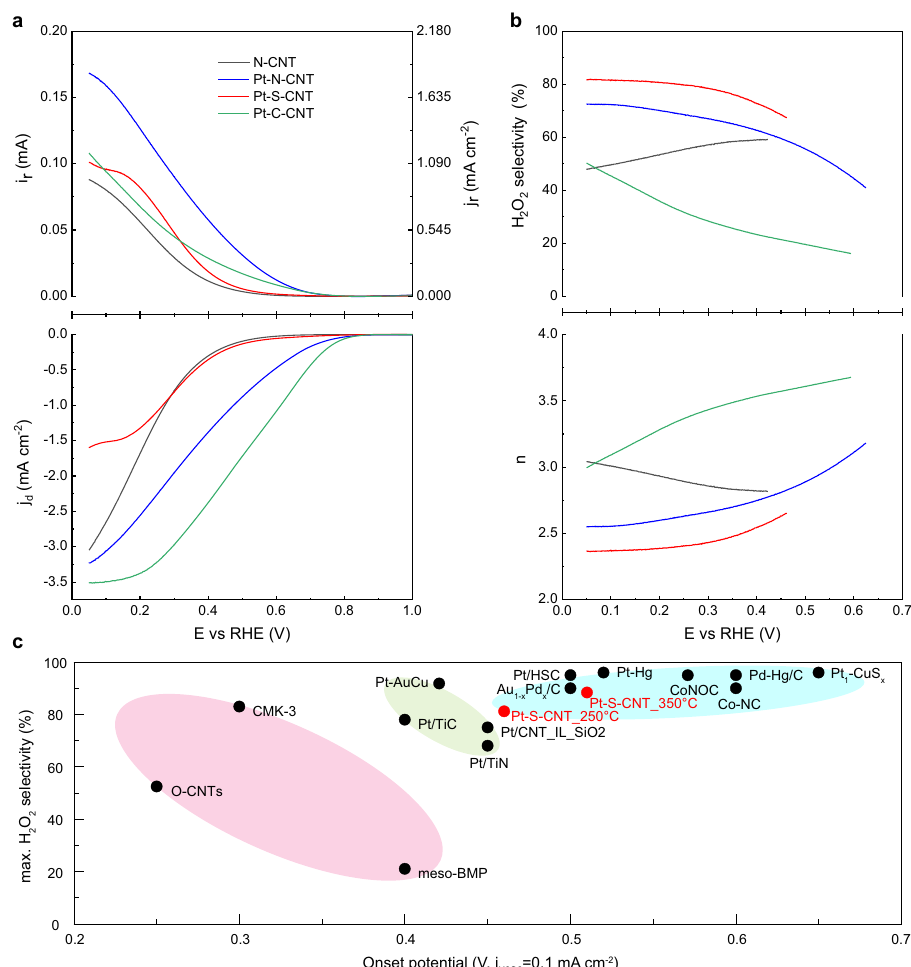
Fig. 2 ORR performance of Pt-X-CNT catalysts cast RRDE in 0.1 M HClO 4 . a Linear sweep voltammetry (LSV) of Pt-N-CNT (blue), Pt-S-CNT (red), Pt-C- CNT (green) and N-CNT reference recorded at 1600 rpm and a scan rate of 5 mV s − 1 , together with the detected H 2 O 2 currents on the ring electrode (upper panel) at a fi xed potential of 1.2 V vs. RHE. The catalyst loading was fi xed at 0.1 mg cm − 2 . b Calculated H 2 O 2 selectivity and electron transfer number ( n ) during LSV scan. H 2 O 2 selectivity and n were plotted from the onset potential that reached 0.1 mA cm − 2 H 2 O 2 partial current density. c Performance map for the electrocatalytic O 2 -to-H 2 O 2 conversion in acidic electrolyte, the detailed sample information could be found in